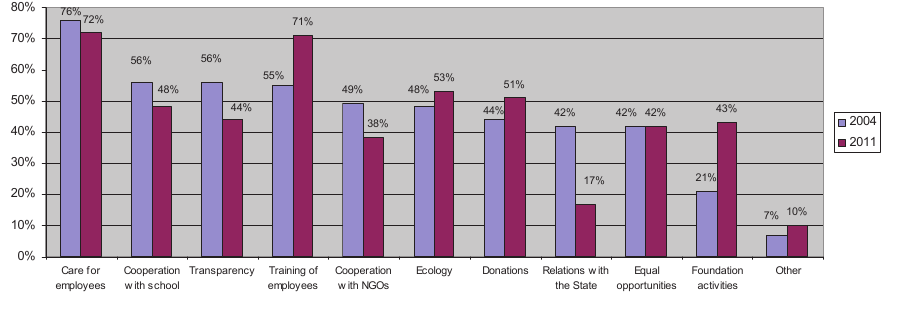
Fig. 2 - Motivation for CSR (2011). Source: own